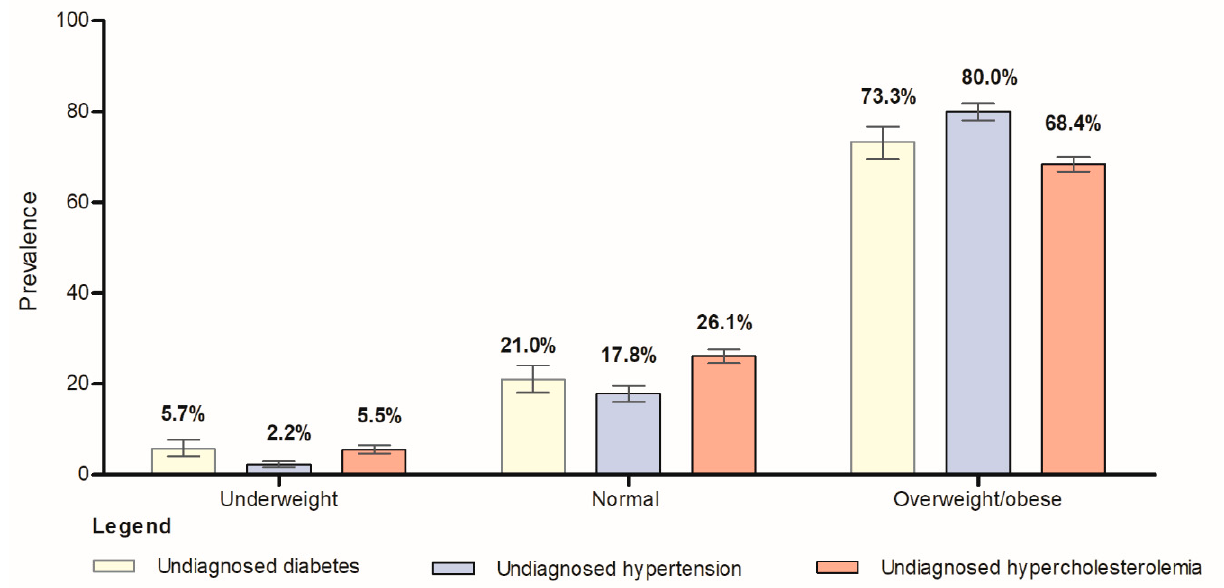
Figure 1. The prevalence of undiagnosed diabetes mellitus, undiagnosed high blood pressure, and undiagnosed hypercholesterolemia stratified by general obesity status among the Malaysian adults ( n = 13,024).